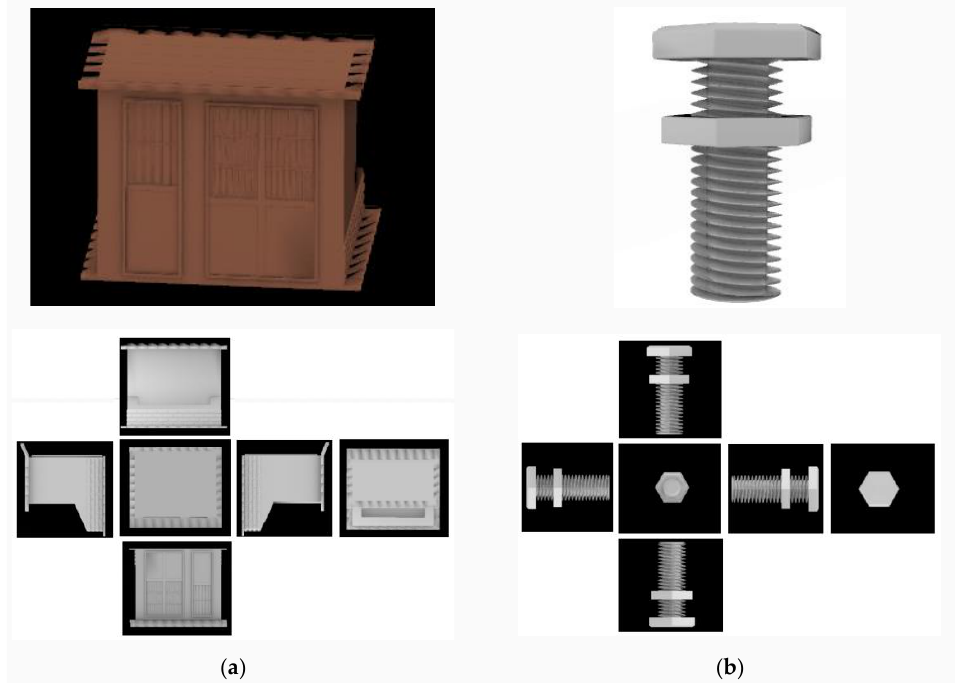
Figure 5. Two-dimensional image of the model obtained by the means of Shih et al. [16]. ( a ) Garbage room, ( b )